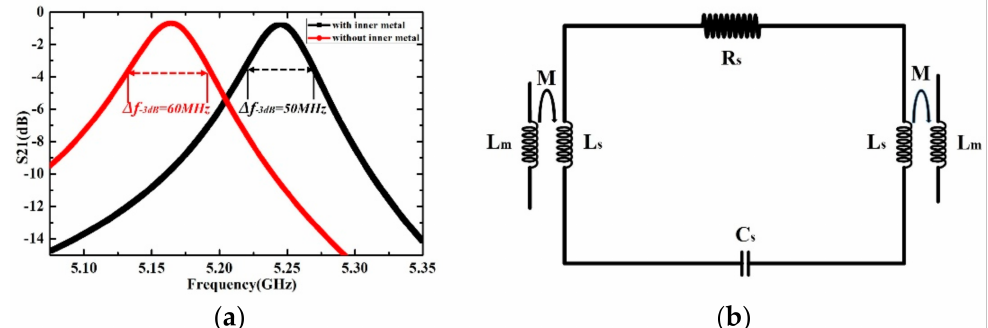
Figure 3. ( a ) Numerically resolved transmission magnitude curve of the microwave sensor ( b ) Equiv- alent circuit with Lm for the inductance of the microstrip coupling line, RLC for the parasitic elements of the SRR structure, and M for the mutual inductance between the coupling line and the SRR